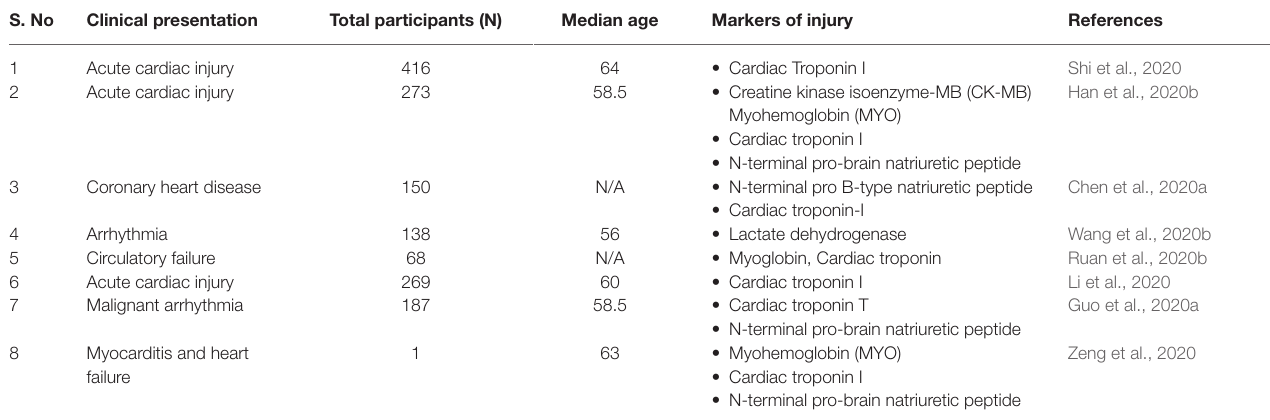
TABLE 1 | Cardiovascular complications caused by SARS-CoV-2